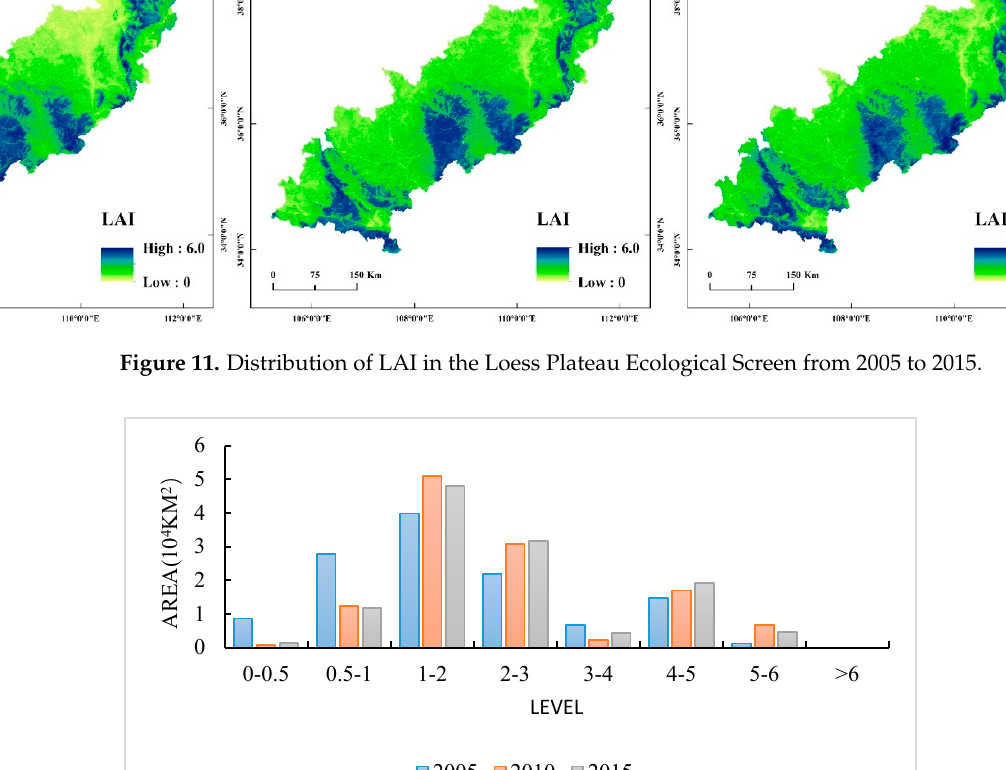
Figure 11. Distribution of LAI in the Loess Plateau Ecological Screen from 2005 to 2015.